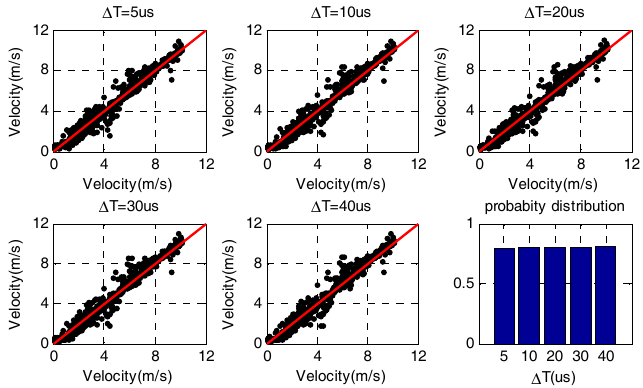
Figure 11. Velocity estimation bias and probability distribution of FDPP at different ∆ T . The red line in the scatter plots represents the zero-deviation standard, and the histogram indicates the probability of velocity bias being less than 0.5 m/s.